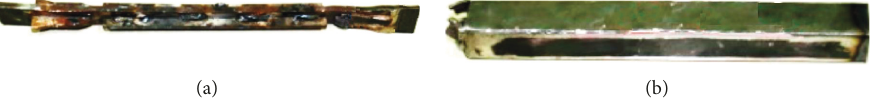
Figure 8: Cyclic loading protocol.